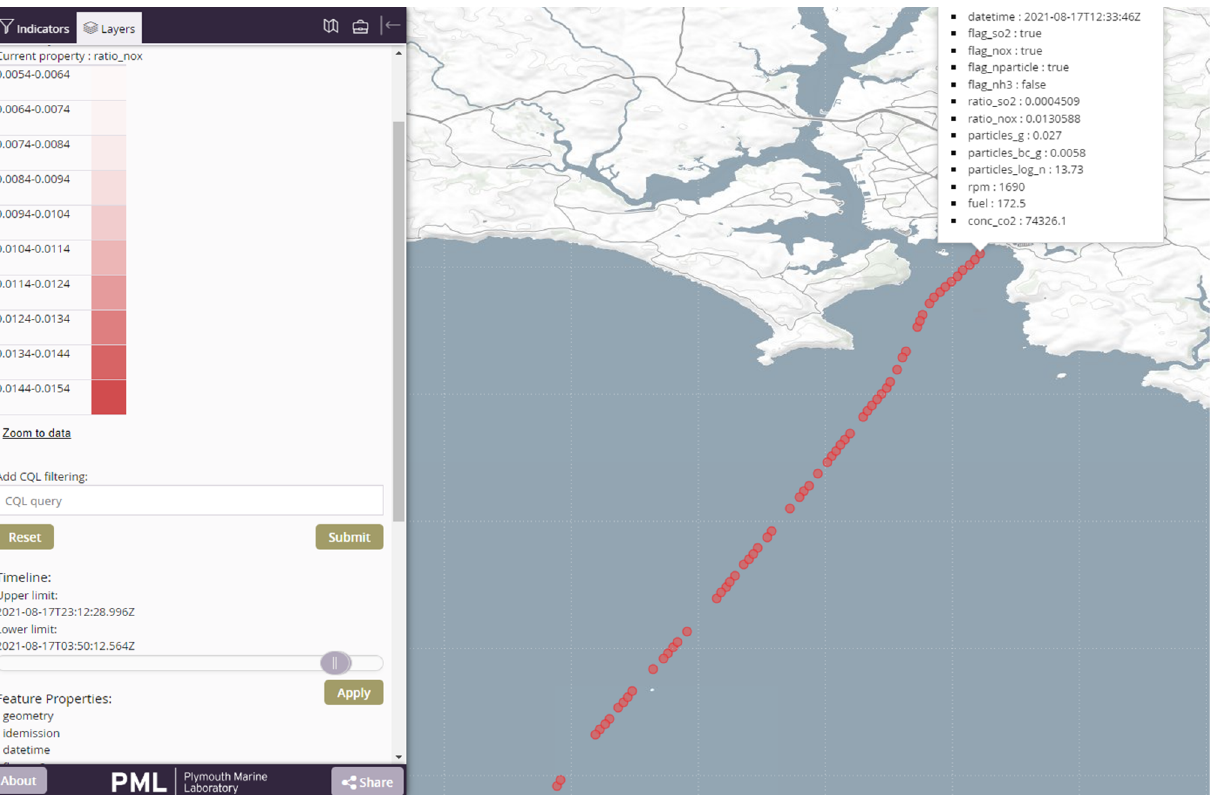
Figure 14 . Red circles show position of successfully received exactSeNS S-AIS messages from a single voyage to 30 km offshore Plymouth by RV Plymouth Quest on 17 August 2021, with shading representing the “ratio_nox” (NO x /CO 2 ).